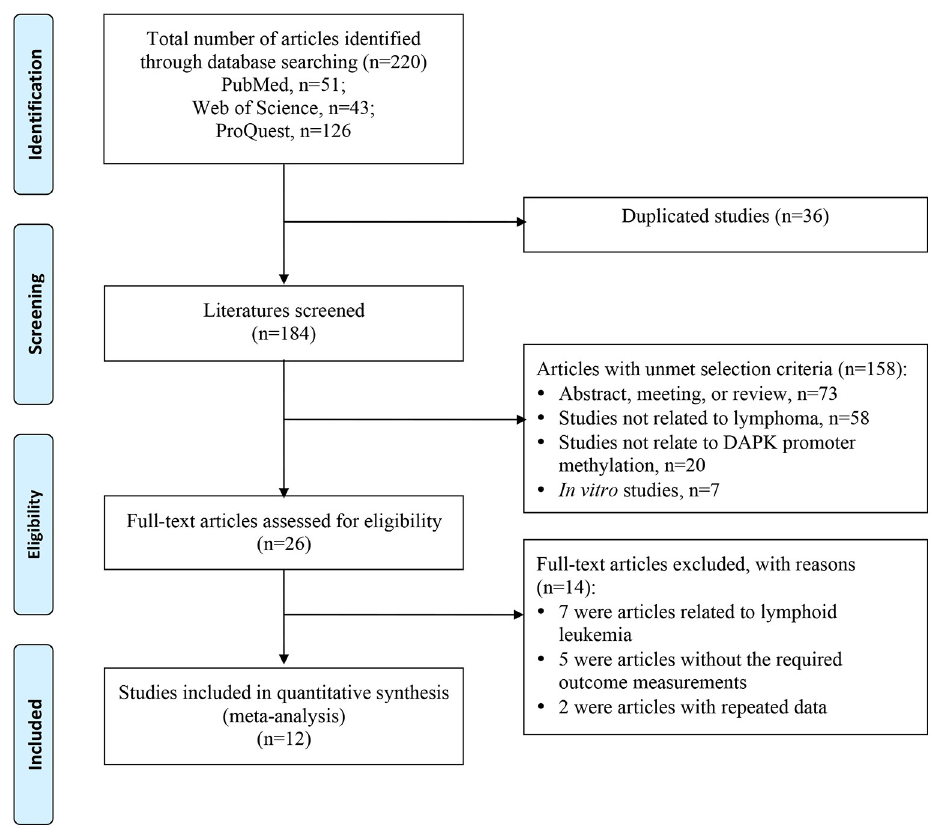
Fig 1. Flow diagram of study